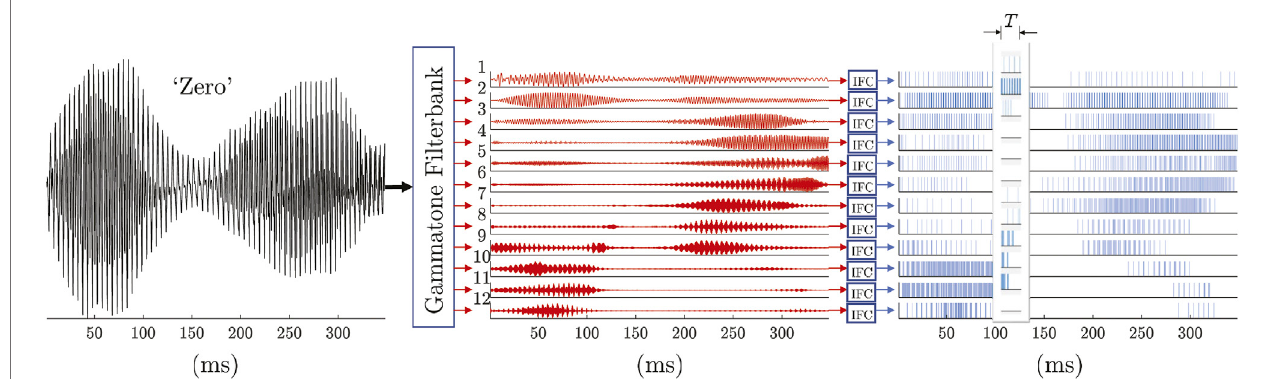
FIGURE 3 | Pulse train front-end for speech recognition: speech signal (sampled at 16 kHz) fi rst passes through a 12-channel gammatone fi lterbank with center frequencies equally spaced between 50 Hz and 8 kHz on the ERB-rate scale, then converted into pulse trains using leaky integrate-and- fi re neurons or IFCs. This encodesthetimeseriesintoabiologically-inspired,highly-ef fi cientsparse representation withmeanspike countper frame( T (cid:1) 25 ms)ranging from0.42 — 25.49across different channels and digits.